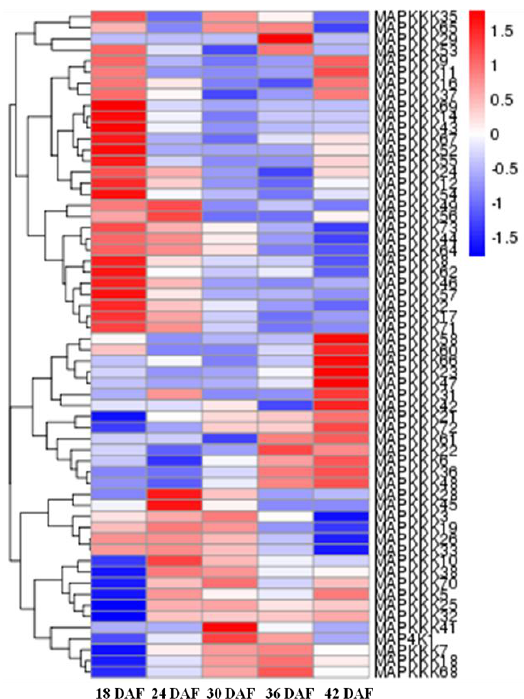
Figure 6. RNA-seq data showing FvMAPKKK gene expression in different fruit developmental stages. The gene expression levels were showed by the color box from blue to red indicating from low to high for each gene; 18–42 DAF, five developmental stages of days after flowering.